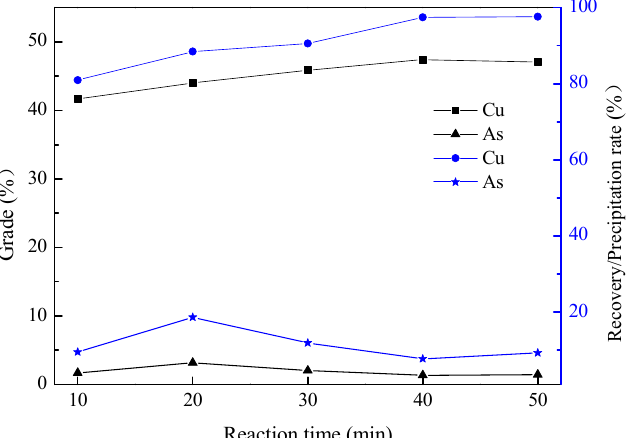
Figure 5. Effect of different reaction times on copper selective recovery (molar ratio of SRSP to copper: 1:1, pH value: 0.70).